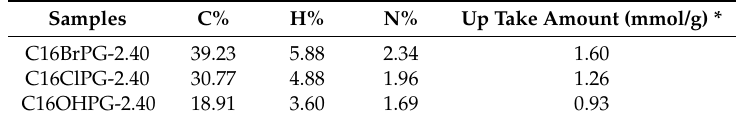
Table 1. C, H, N elemental analysis of different OCs prepared at different